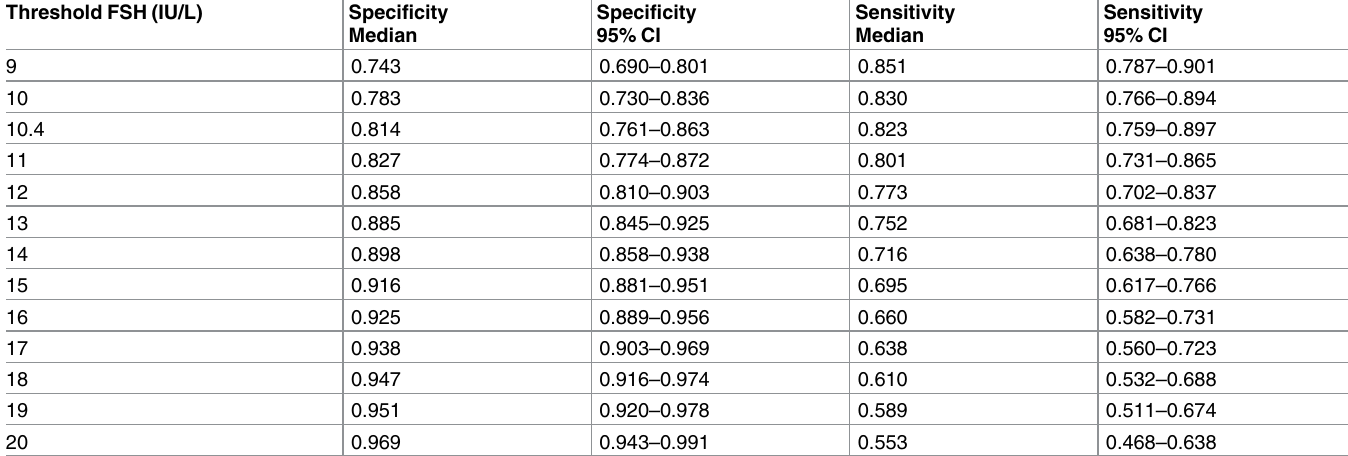
Table 2. Sensitivity and specificity of FSH-based azoospermia diagnosis for a range of threshold values. Median and 95% CI are calculatedfrom 2,000 stratified bootstrapreplicates of the combineddata (n = 367). Threshold FSH